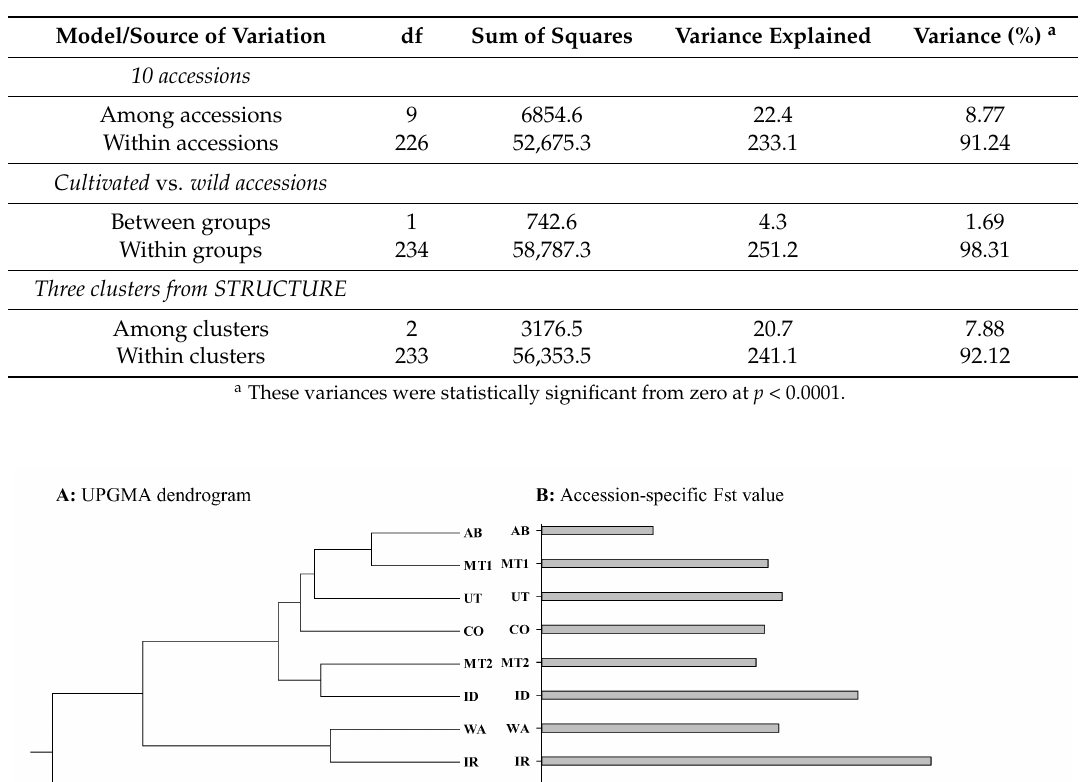
Table 2. Results of the analysis of molecular variance for three models of genetic structure (10 accessions, cultivated vs wild accessions, and the three clusters from the STRUCTURE analysis) based on the 5659 SNP markers.